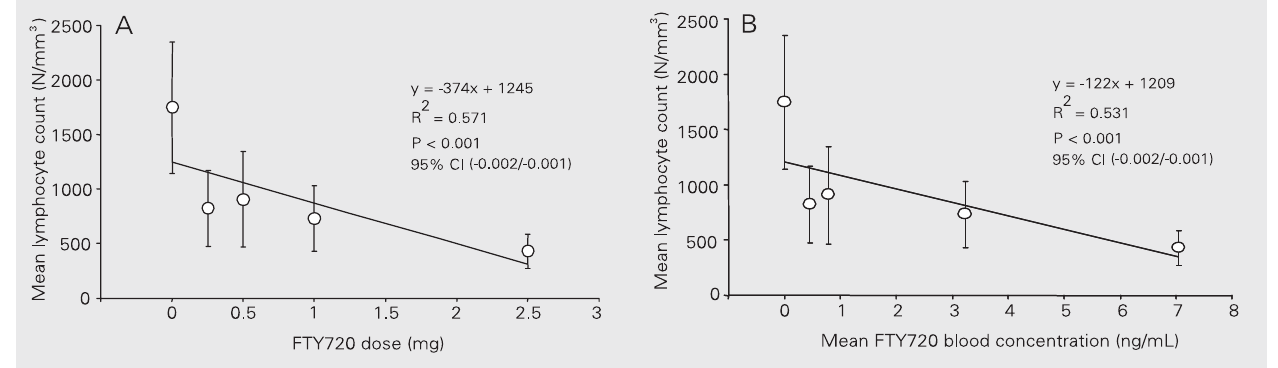
blood.Figure Figure 6. Pharmacokinetic and pharmacodynamic inhibitory E max model correlating FTY720 dose (A) or blood concentration (B) with absolute lymphocyte counts in peripheral Figure 7. Pharmacokinetic and pharmacodynamic simple E max model correlating FTY720 dose (A) or blood concentration (B) with percent reduction in lymphocyte counts in peripheral